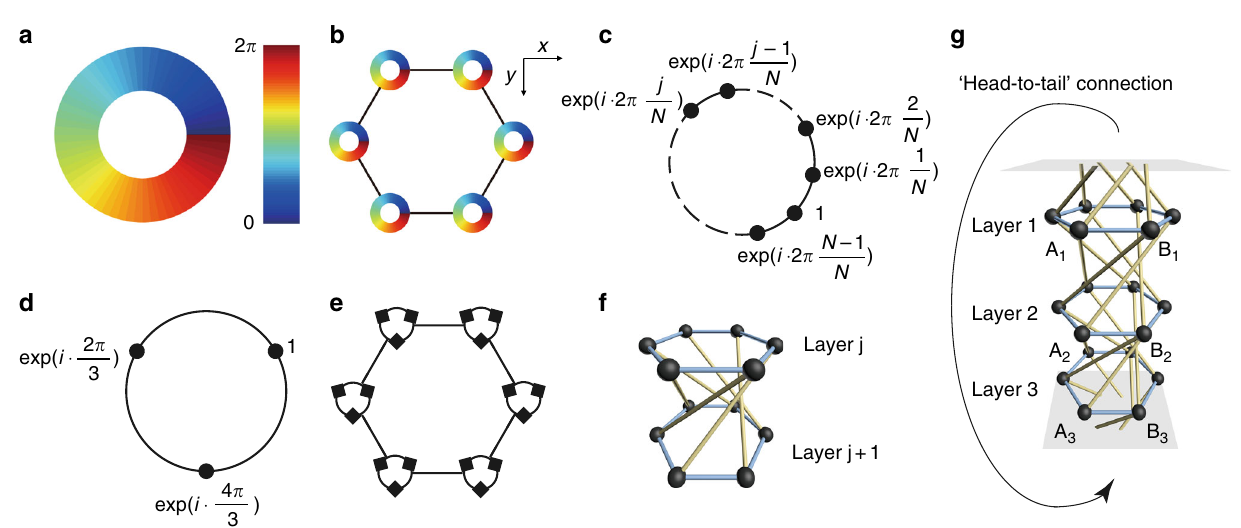
Fig. 1 Realization of angular-momentum-orbital coupling in 2D honeycomb lattices. a Phase distribution of a mode with angular momentum m = 1. b A honeycomb lattice with sites exhibiting non-zero angular momentum. c A discrete set of N point nodes, where each carries a different phase, can emulate a mode with non-zero angular momentum. d A minimum of three nodes is needed to create a nontrivial topology. e A discretized version of the honeycomb lattice in ( b ), with each site carrying three nodes. The three nodes need not lie geometrically on the same plane. f An exemplary connection which exhibits nontrivial angular-momentum-orbital coupling. Here a layer represents the lattice structure formed by the nodes with the same sequence number j (as shown in ( c )) of different loops on each lattice site. Black spheres represent nodes. The bonds in blue and yellow indicate intralayer and interlayer couplings, respectively. g An N = 3 example. The ‘ head-to-tail ’ connection here means layer 1 is connected to layer 3 via the same connections as those shown in ( f ). The loop formed by the nodes A 1 , A 2 and A 3 ( B 1 , B 2 and B 3 ) represents the meta-atom on the sublattice A ( B